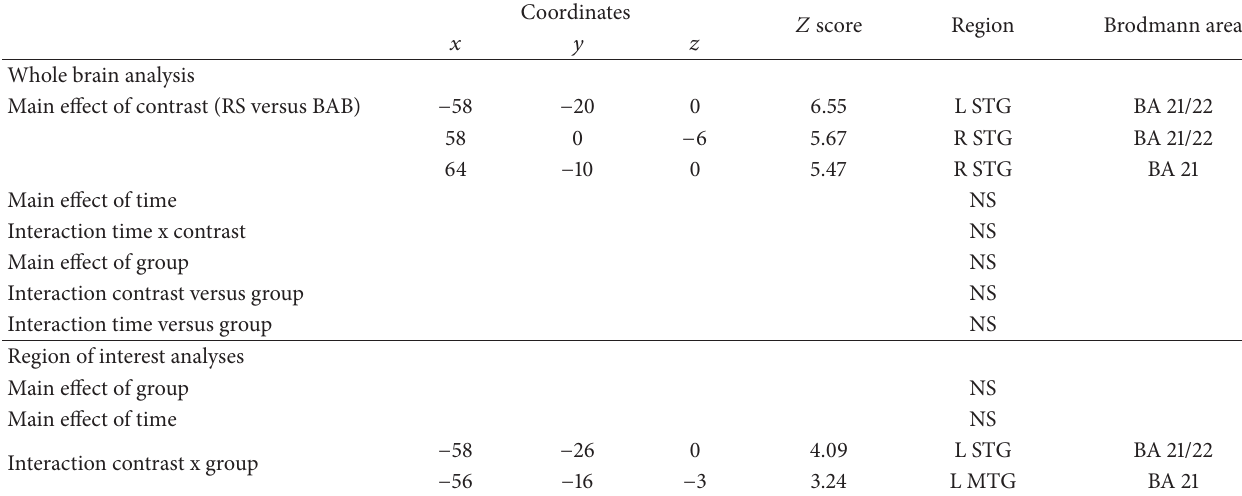
Table 2: Main effects and interactions of analysis 1 performed across CI participants on the whole brain (top) and on a region-of-interest based on main effect of contrast (bottom).